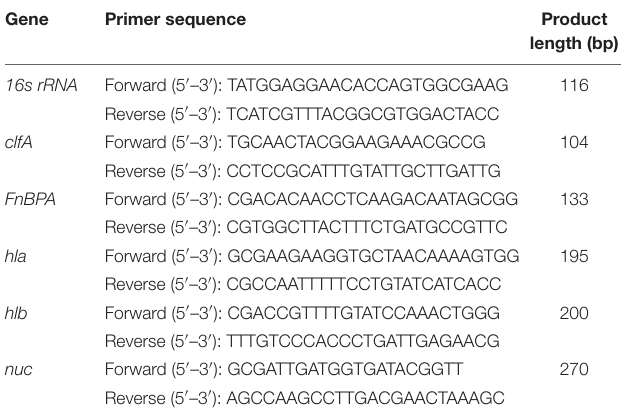
TABLE 1 | Primers for virulence gene of S. aureus . Gene Primer